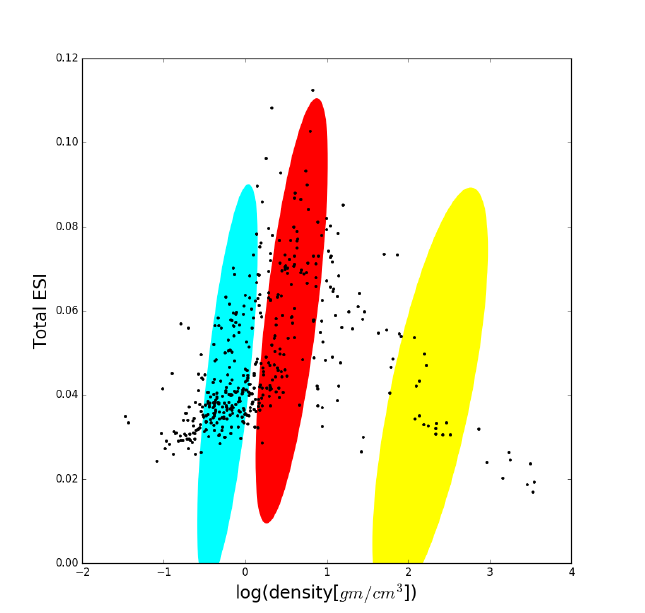
Figure 6. The scatter plot of the distribution using the two components, log (density) and total ESI. The three ellipses represent the 1 σ confidence level region for the 3-component model, which are centered at the means of the distribution acquired from best-fit of Eq. 6 and Eq. 8.